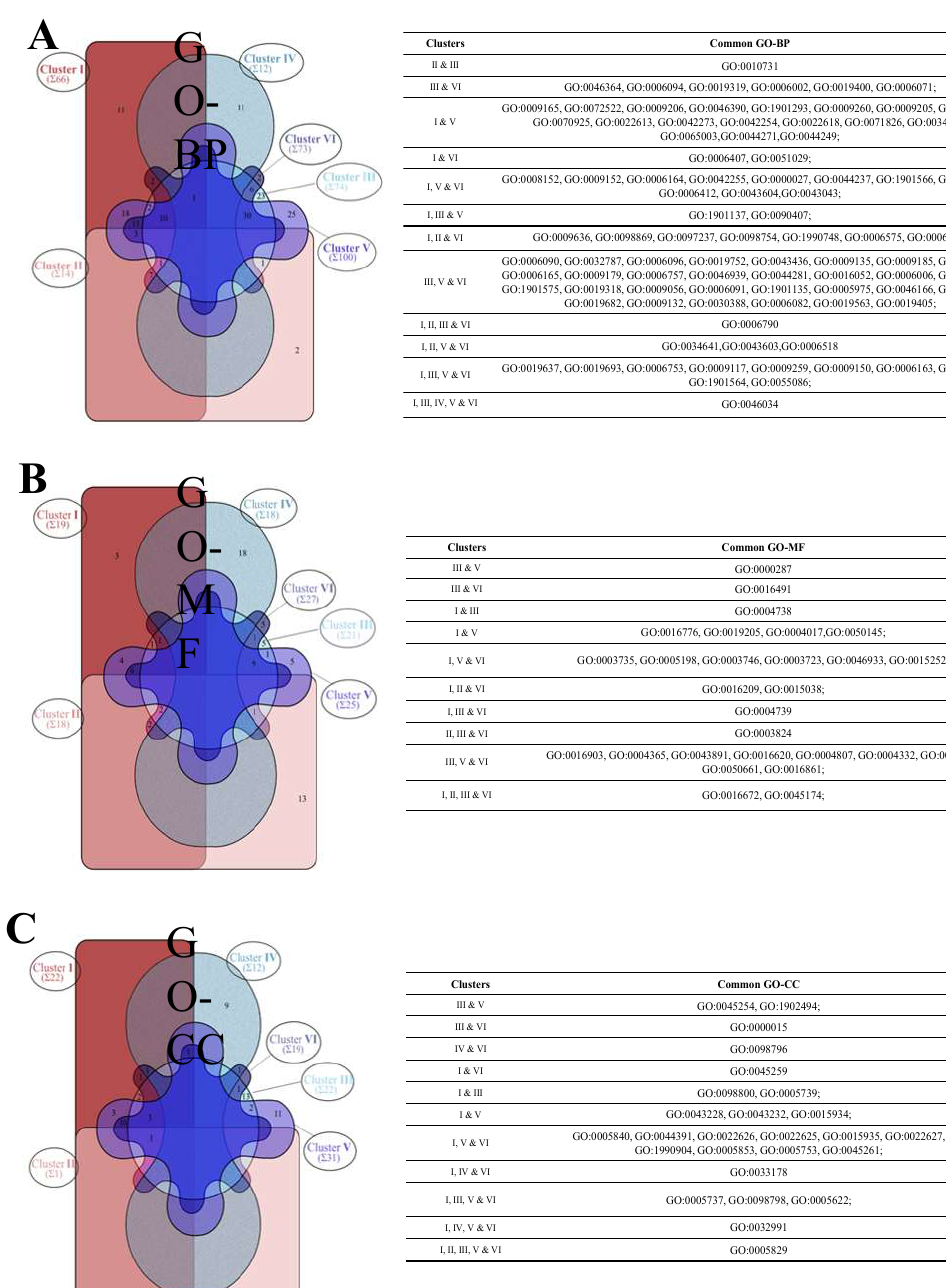
Figure 3. Distribution of GO terms in the cluster-related subnetwork (I–VI). GO term differences and overlaps among subnetworks were interpretated by Interactivenn [36]. Venn diagram (Edward’s style) shows the number of common or specific GO-BPs among subnetworks (I–VI) across the three domains, GO-BP (panel A ), GO-MF (panel B ), and GO-CC (panel C ). Common GO-BP, GO-MF, and GO-CC terms of panel ( A – C ) are listed in the Table, respectively. The list of all specific GO terms is reported in Table